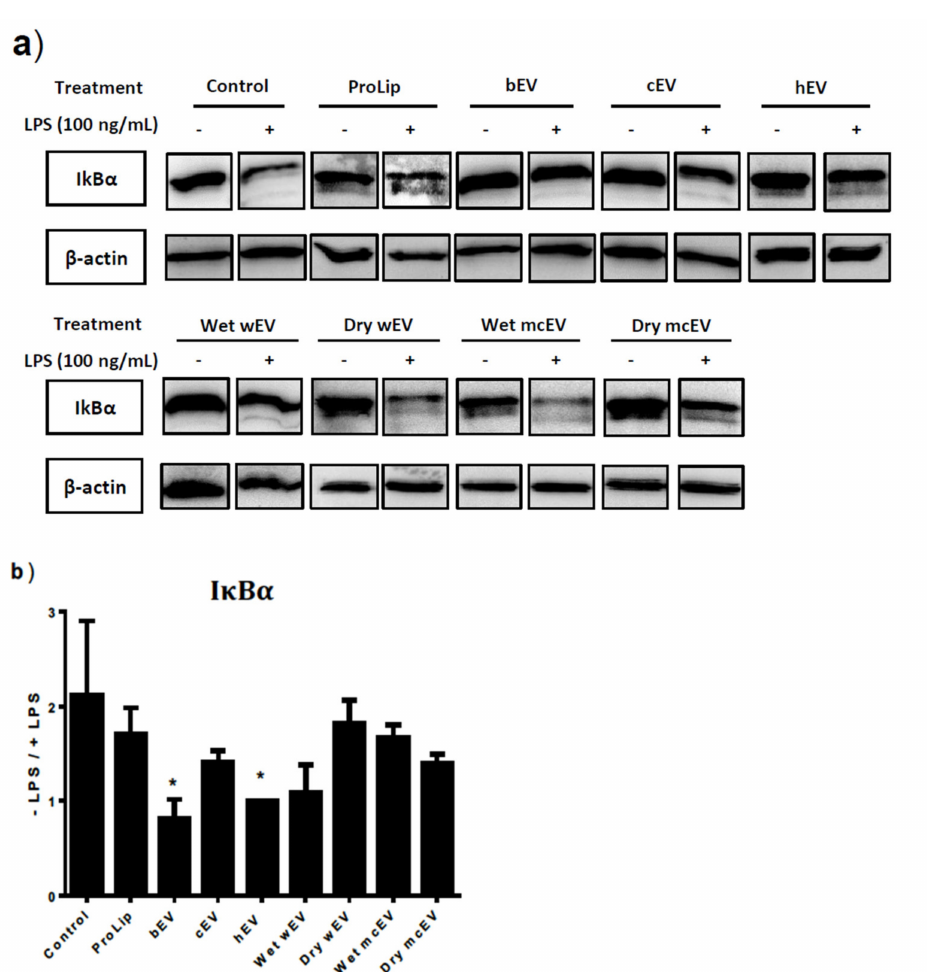
Figure 5. Evaluation of NF- κ B pathway activation. ( a ) Western blots were carefully loaded with RAW264.7 cell lysates (50 µ g protein/well) after treatment with the given EV isolate or control followed by LPS stimulation. β -actin was used as loading control to normalize data. The original Western blots can be seen in Figure S3. ( b ) Quantification of the bands shown in Figure 5a, depicted as a ratio between non-LPS-treated cells/LPS-treated RAW264.7 cells. The bands were quantified using ImageJ. All ratios were compared to the control by a Student’s t -test. * p -value < 0.05 vs. the control. The results were obtained by a minimum of two independent experiments. See Table 1 for sample